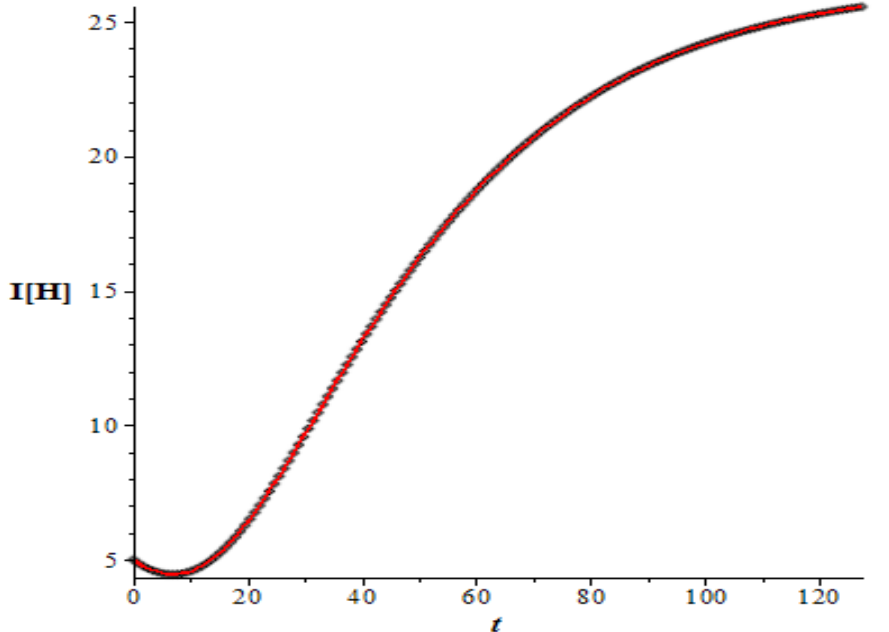
Figure 10. The figure shows the graphs of human infective population I H ( t ) when there is a replace- ment of natural mosquitoes by the population of wolbachia infected mosquitoes, assuming there is a decrease of infection rates in data set 1 in Table 1 to half of the original rates, and an increase of mosquito mortality rate in data set 1 in Table 1 to double the original mortality